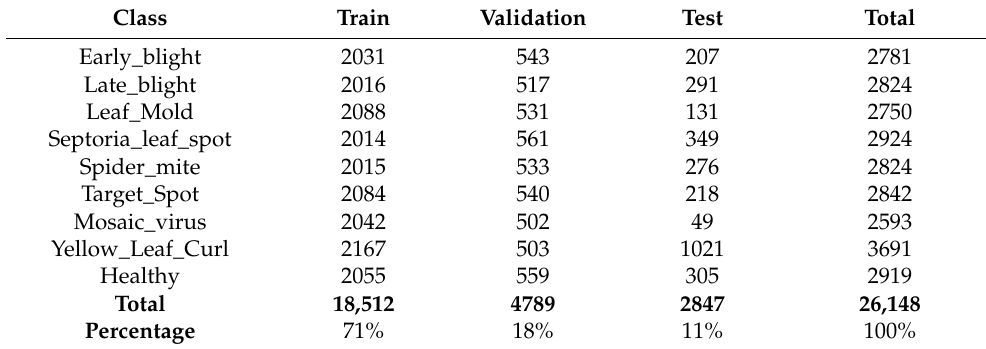
Table 2. Number of images in the new dataset. Training, validation, and test